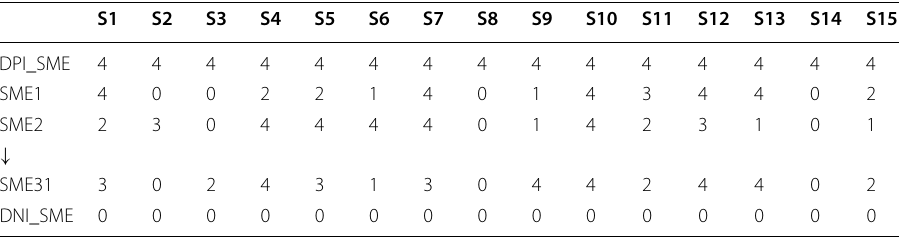
Table 8 Conversion of the data of Table 7 by using the scale